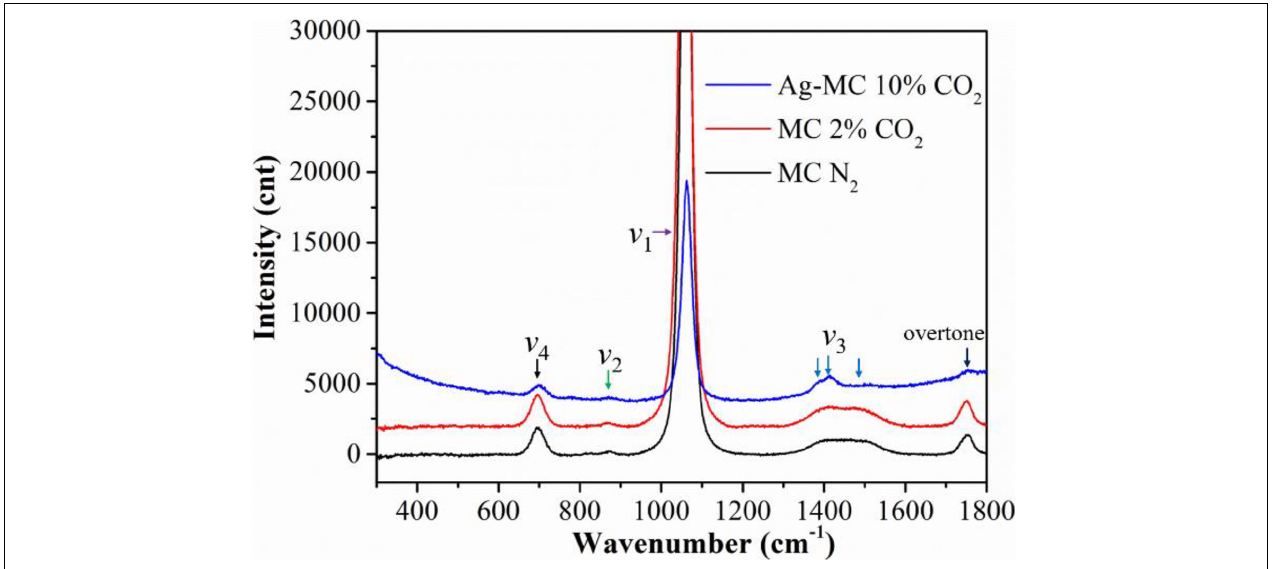
FIGURE 1 | The Raman spectra of the MC/Ag-MC samples at 575 ◦ C in dry gas atmospheres with different CO 2 concentration. (N 2 : gas #1, 2% CO 2 : gas #2, 10% CO 2 : gas